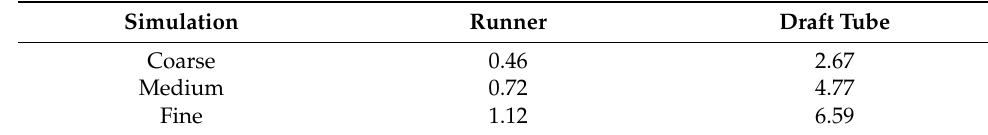
Table 3. Nodes (10 6 ) in meshes used for runner and draft tube